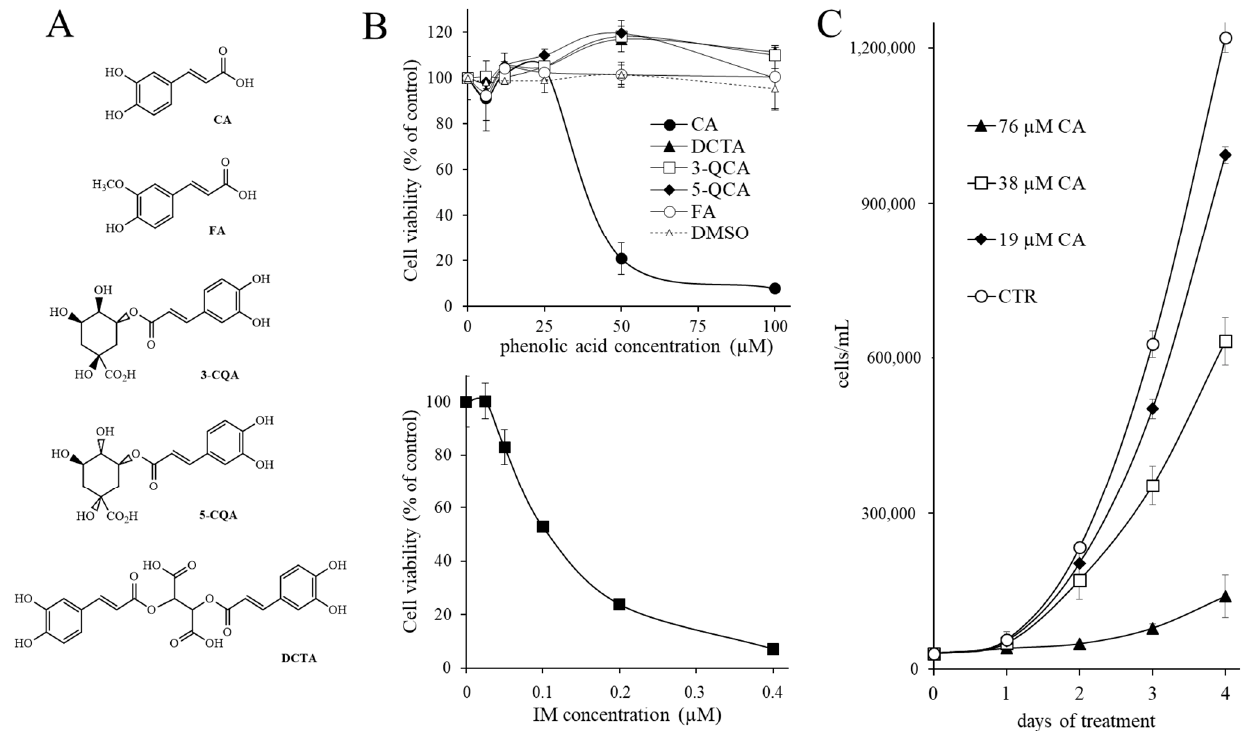
Figure 1. Effect of phenolic acids on the viability of the human K562 cells. ( A ) Structures of the molecules investigated. Caffeic acid (CA), ferulic acid (FA), chlorogenic acids (3-CQA), neochlorogenic acid (5-CQA) and chicoric acid (DCTA). ( B ) Cell viability evaluated by MTT assay three days after the drug administration, expressed as a percentage with respect to control cells left untreated. Upper panel: dose-dependent effects of phenolic acids. Lower panel: dose-dependent effects of imatinib (IM). ( C ) Time-dependent effects of CA on the number of viable cells assayed by Trypan blue dye exclusion. The results were expressed as arithmetic mean ± standard deviation.